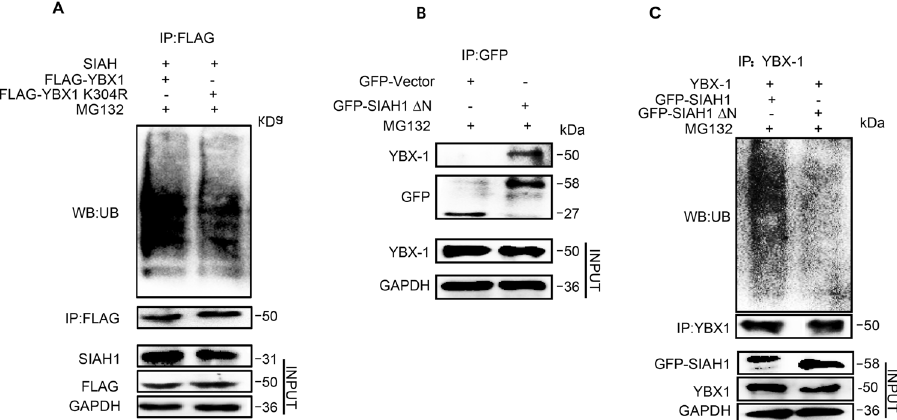
Fig. 6 SIAH1 ubiquitinated YBX-1 at its K304 through RING domain. A HEK293T cells were transfected with the indicated constructs, and treated with MG132 for 6 h. Then the cell lysates were immunoprecipitated with anti-FLAG antibody. Detcting ubiquitinated YBX-1 with anti- UB antibody. B IP of GFP-SIAH1 Δ N and YBX-1. 293 cells stably expressing GFP-SIAH1 Δ N were pulled down by anti-YBX-1 and immunoblotted with anti-GFP. C HEK293T cells were cotransfected with YBX-1 and GFP-SIAH1, YBX-1 and GFP-SIAH1 Δ N, respectively. The levels of Ubiquitinated YBX-1 were detected by